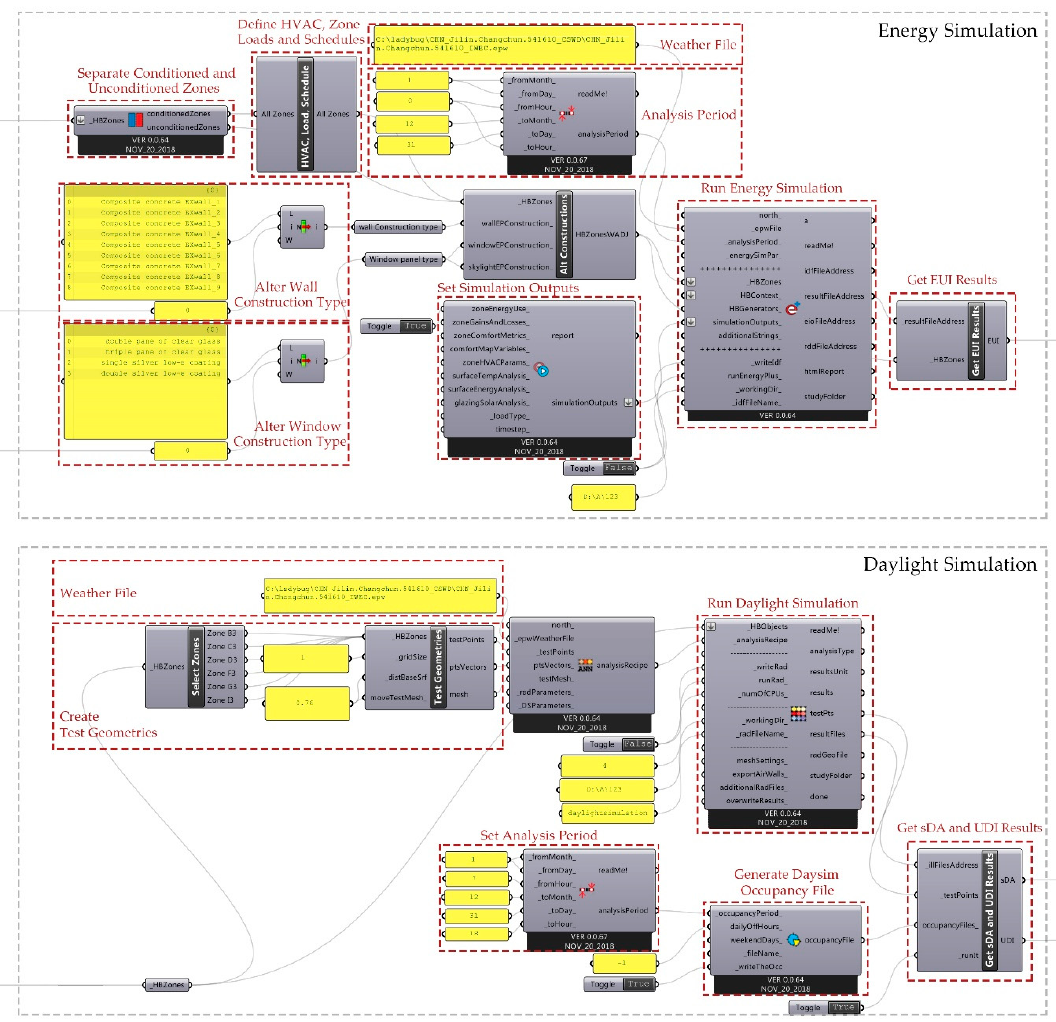
Figure 8. Energy and Daylight Simulation module.